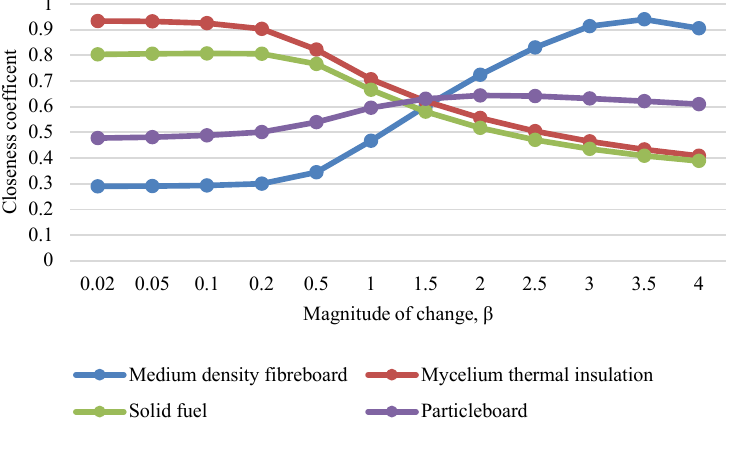
Fig. 4. TOPSIS results sensitivity analysis. Sensitivity analysis is conducted by changing weight of product market price and re-calculating the rest of assigned weights. X-axis depicts magnitude ( β ) of change of product market weight and y-axis depicts the closeness coefficient of all alternatives to the ideal solution.